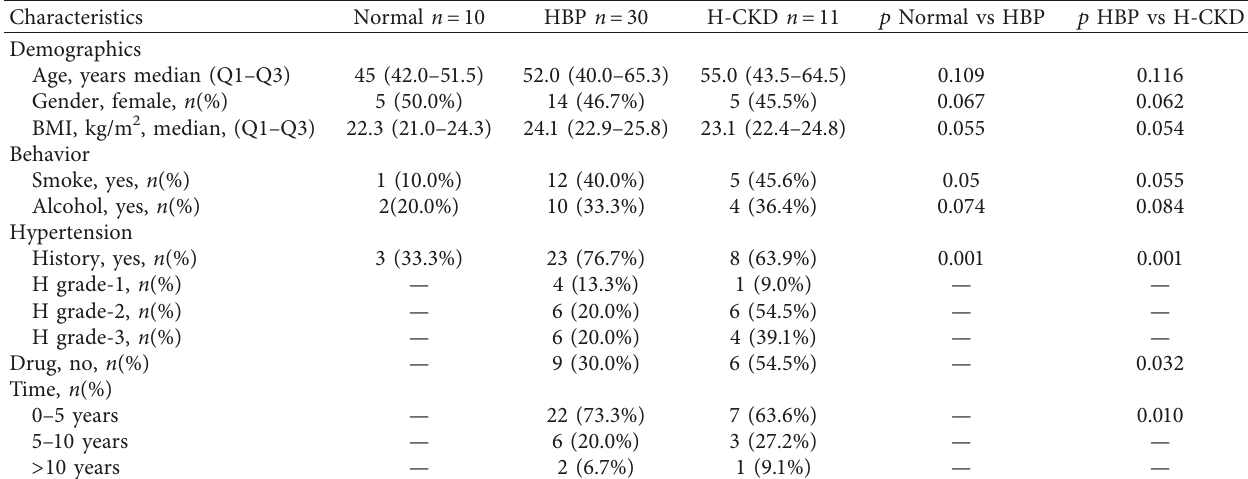
Table 1: Characteristics information of experimental